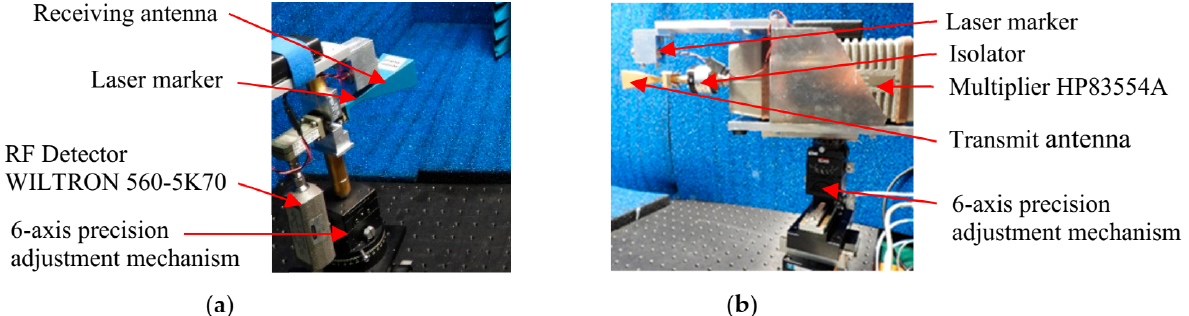
Figure 7. ( a ) Receiving antenna and RF Detector; ( b ) Multiplier and transmitting